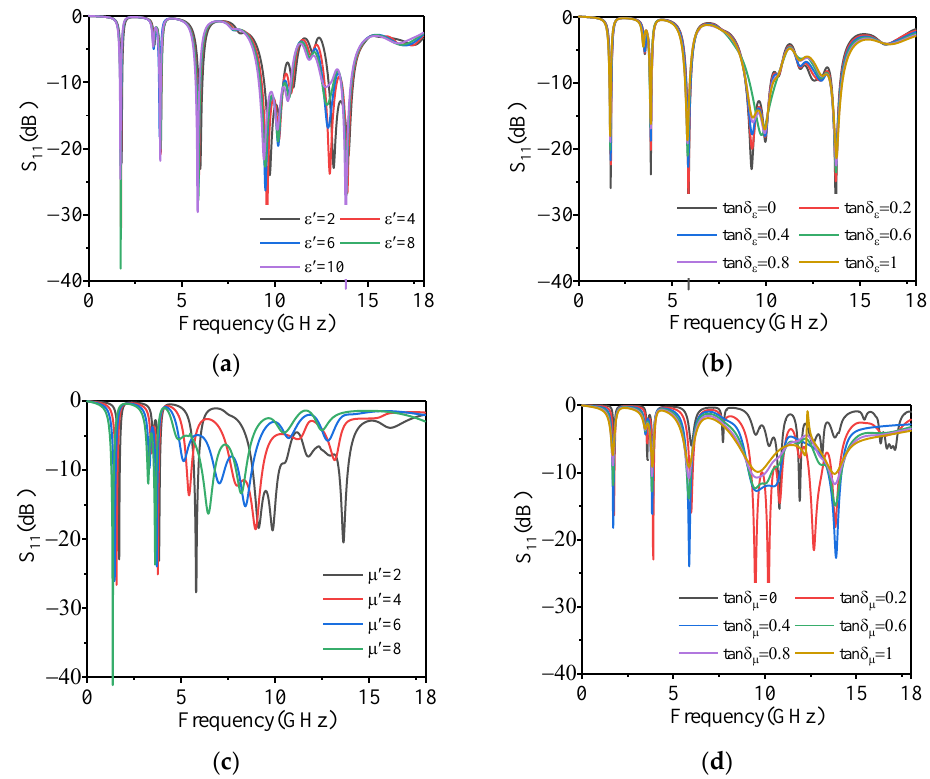
Figure 5. The effect of the EM parameters of the magnetic substrate on the absorption of the proposed absorber; ( a ) is the real part of permittivity, ( b ) is the dielectric loss, ( c ) is the real part of permeability, and ( d ) is the magnetic loss.